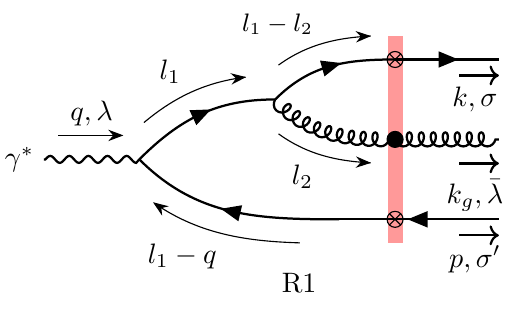
Figure 5 . Real gluon emission from quark before scattering from shock